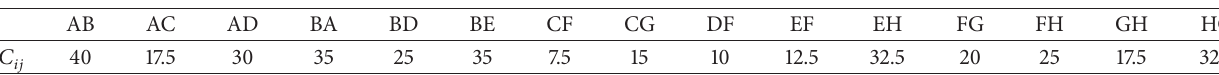
Table 4: The cost.